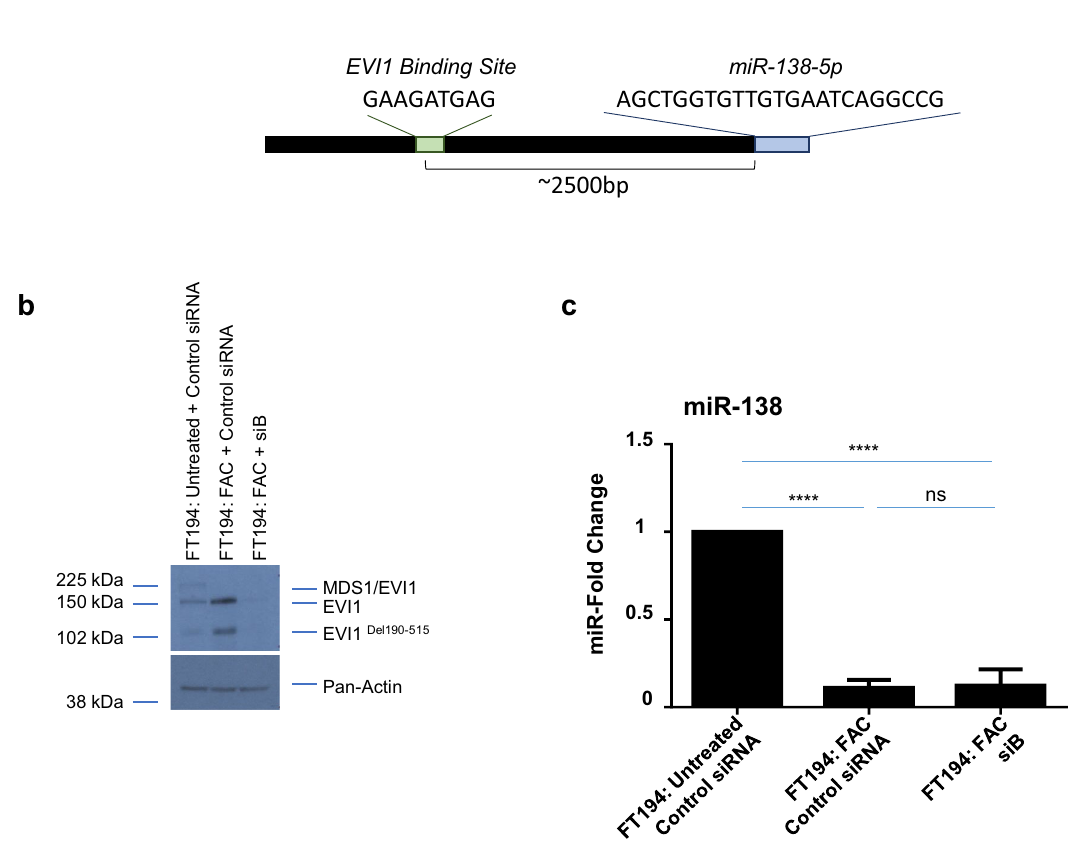
Figure 7. EVI1 knockdown does not alter miR-138-5p expression level. ( a ) Schematic representing the predicted EVI1 binding site upstream from miR-138-5p. EVI1 splice variants were reduced in FAC-treated FT194 cells using siRNA (siB) in FAC-treated cells. Cell lysates and miRNAs were collected at days 125 and 128 of FAC treatment ( p = 37 and 38). ( b ) Western blotting was performed to validate the knockdown. Three independent experiments were completed and a representative blot is shown. ( c ) Real-time PCR of miR-138-5p was performed using RNU6B as a reference control. The data represents the composite of three independent experiments. White space between cropped blots delineate different antibody applications to the same blot. The full-length uncropped blots are displayed in the Supplementary Information